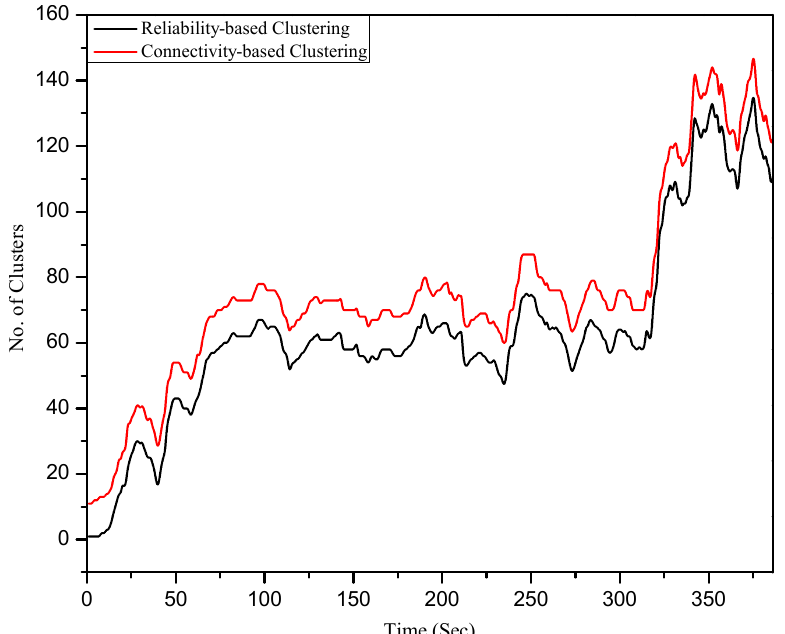
Figure 2. Temporal assessment of connectivity-based clustering (our suggested scheme) and reliability-based clustering scheme